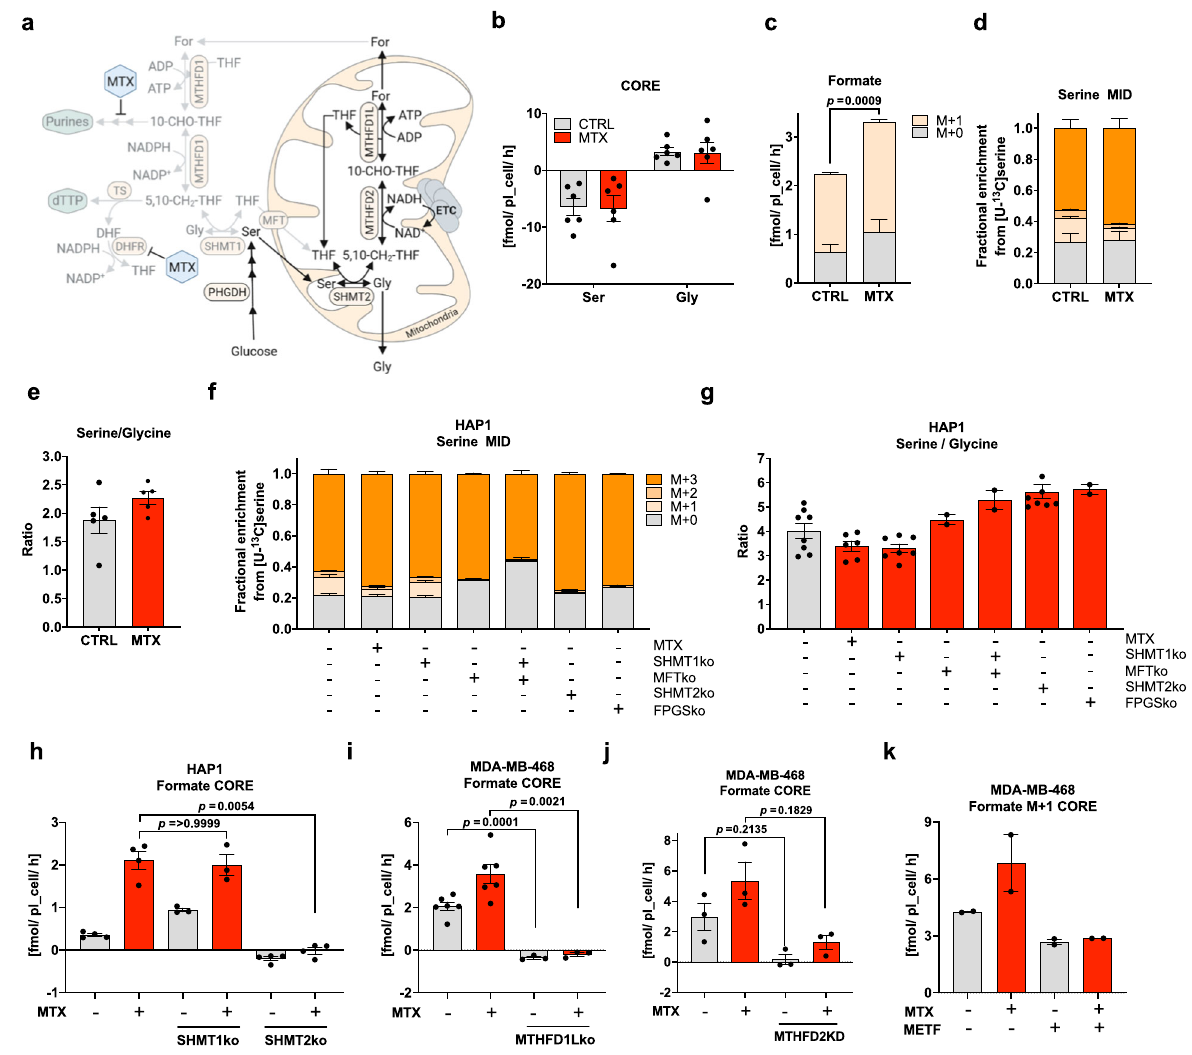
Fig. 4 Mitochondria protect 1C metabolism-dependent serine catabolism upon cytosolic 1C pathway inhibition. a Cytosolic and mitochondrial 1C metabolism and the pharmacologic intervention points of MTX. b Absolute consumption and release (CORE) rates of serine (Ser) and glycine (Gly) from MDA-MB-468 cells upon 24 h 50 nM MTX. Dots represent the mean of an individual experiment each measured in triplicate wells; mean ± SEM ( n = 6). c Formate release rate upon [U- 13 C]serine in MDA-MB-468 cells after 24 h 50 nM MTX; mean ± SEM of three independent experiments each measured in triplicate wells; unpaired t -test with Welch ’ s correction for M + 1 isotopologue ( n = 3). d MID of intracellular serine upon [U- 13 C]serine in MDA-MB-468 cells upon 24 h 50 nM MTX; mean ± SEM of four independent experiments each measured in triplicate wells. e Ratio of absolute intracellular serine and glycine after 24 h 50 nM MTX in MDA-MB-468 cells. Dots represent the mean of an independent experiment in triplicate wells; mean ± SEM ( n = 5). f MID of intracellular serine upon [U- 13 C]serine in SHMT1, MFT, SHMT2, and FPGS-depleted HAP1 cells; mean ± SEM of independent experiments each measured in triplicate wells ( n = 8 for CTRL, SHMT1ko, and SHMT2ko; n = 5 for MTX; n = 2 for FPGSko, MFTko and MFT/SHMT1ko). g Ratio of absolute intracellular serine and glycine levels in SHMT1, MFT, SHMT2, and FPGS depleted HAP1 cells. Dots represent the mean of an independent experiment in triplicate wells; mean ± SEM ( n = 8 for CTRL and SHMT2ko, n = 7 for SHMT1ko, n = 6 for MTX, n = 2 for FPGSko, MFTko and MFT/SHMT1ko). h Absolute CORE rates of formate from WT and SHMT1- or SHMT2-depleted HAP1 cells upon 24 h 50 nM MTX. Each dot indicates the mean of an individual experiment measured in triplicate wells; Brown-Forsythe and Welch ANOVA test with Dunnetts multiple comparisons test. Mean ± SEM ( n = 4 for CTRL, MTX, SHMT2ko, SHMT2ko MTX; n = 3 for SHMT1ko and SHMT1ko MTX) i Absolute CORE rates of formate from WT and MTHFD1L-depleted MDA-MB- 468 cells upon 24 h 50 nM MTX. Mean ± SEM ( n = 6 for CTRL and MTX; n = 3 for MTHFD1Lko + /- MTX) of an individual experiment measured in triplicate wells; Brown-Forsythe and Welch ANOVA test with Dunnetts multiple comparisons test. j Absolute CORE rates of formate from SCR and MTHFD2 KD MDA-MB-468 cells upon 24 h 50 nM MTX. Dots represent mean of an individual experiment measured in triplicate wells; mean ± SEM; ( n = 3) Brown-Forsythe and Welch ANOVA test with Dunnetts multiple comparisons test. k Absolute CORE rates of formate from MDA-MB-468 cells upon 24 h treatment with 2.5 mM Metformin and 50 nM MTX. Dots represent mean of an individual experiment measured in triplicate wells; mean ± SEM ( n = 2). Source data are provided as a Source Data fi